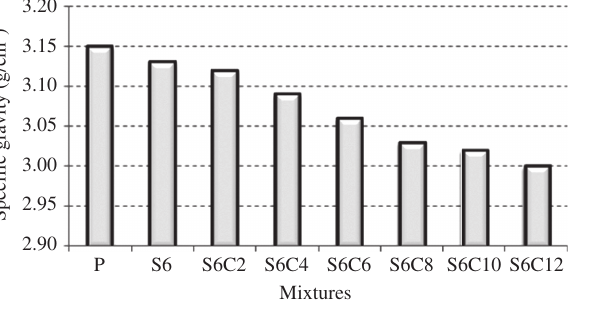
Figure 3 Specific surfaces of mixtures.